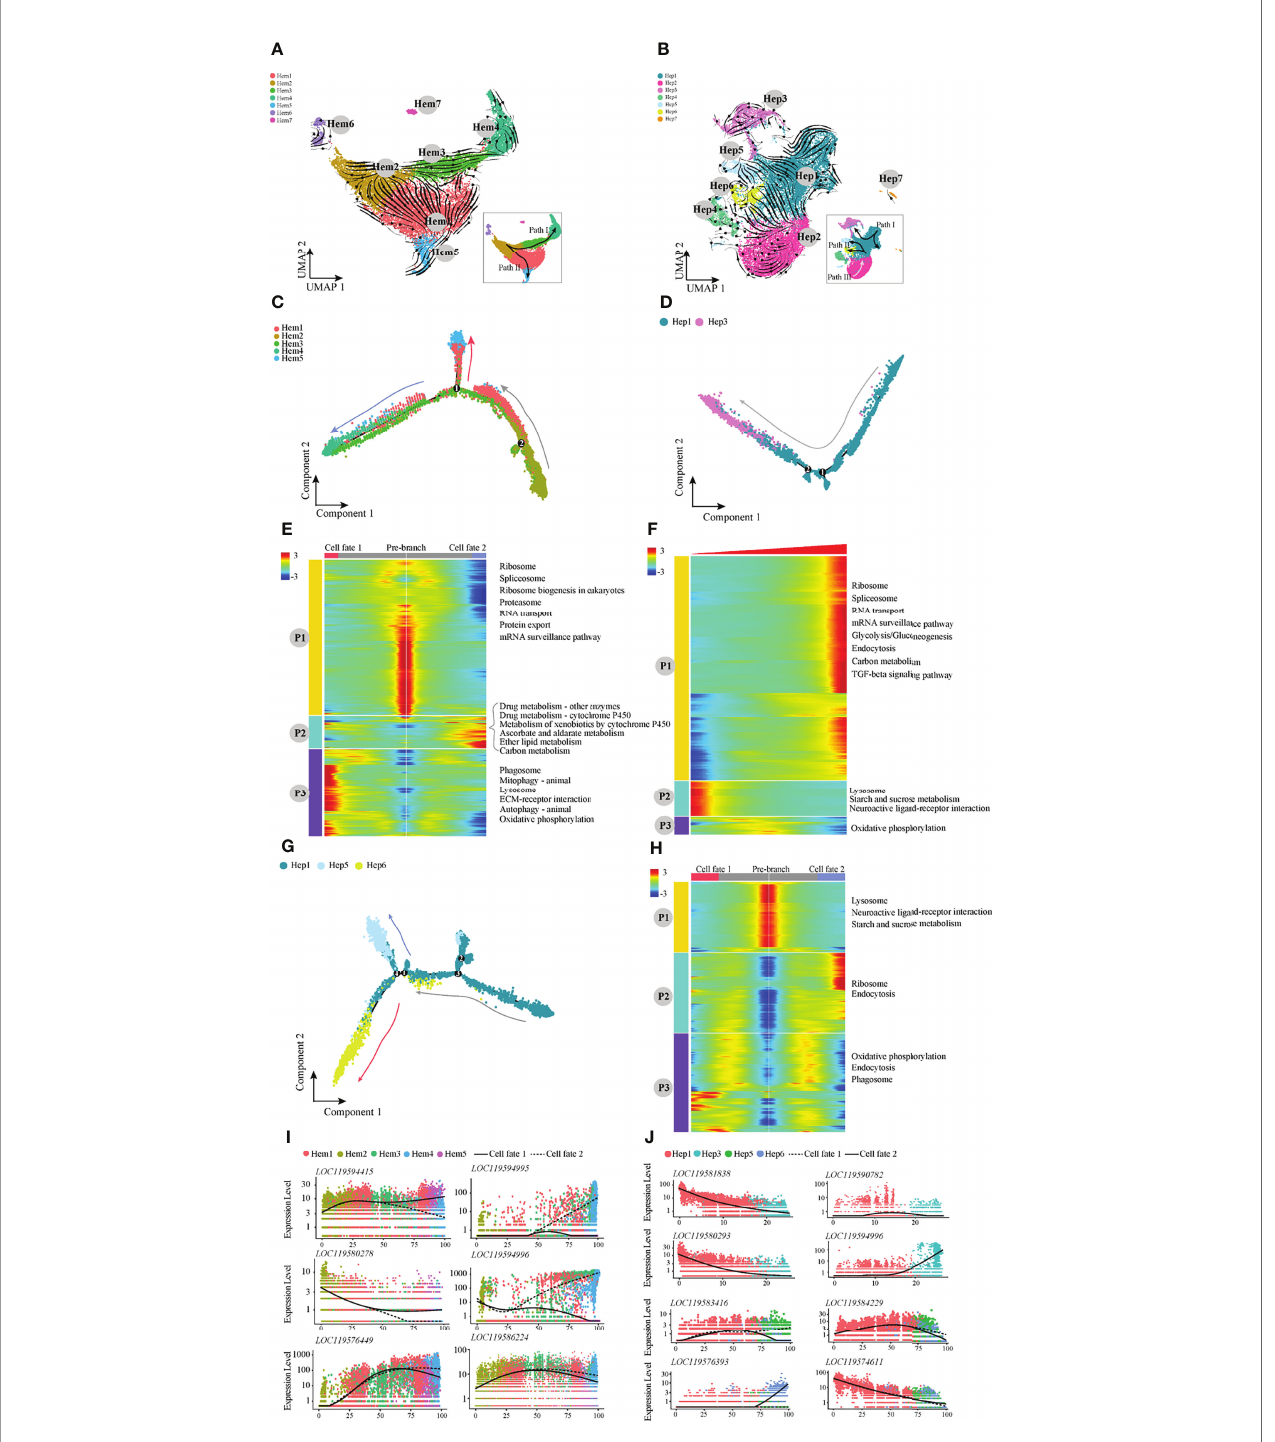
FIGURE 3 | The pseudotemporal trajectories identify transcriptional dynamics of shrimp haemocytes and hepatopancreatic cells. (A) UMAP diagram of the RNA velocity of haemocytes. (B) UMAP diagram of the RNA velocity of hepatopancreatic cells. (C) Pseudotime analysis of cells in Path I and Path II development directions. (D) Pseudotime analysis of cells in Hep1 and Hep3 developmental directions. (E) The pseudotime branch heatmap of haemocytes and KEGG enrichment. (F) The pseudotime branch heatmap of hepatopancreatic cells and KEGG enrichment. (G) Monocle differentiation tree of Hep1/5/6 in hepatopancreas. (H) The branch heatmap of Hep1/5/6 cells and KEGG enrichment. (I) Jitter diagram of branch development of key genes in haemocytes. (J) Jitter diagram of key genes in the developmental direction of hepatopancreatic